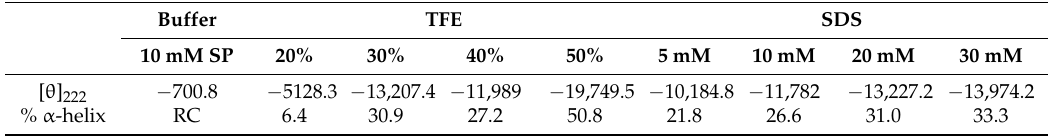
Figure 2. Circular dichroism (CD) spectra of magainin 2. ( A ) The peptide was measured in TFE, which mimics the hydrophobic environment of the microbial membrane and ( B ) SDS, which mimics the negatively charged prokaryotic membrane environment.